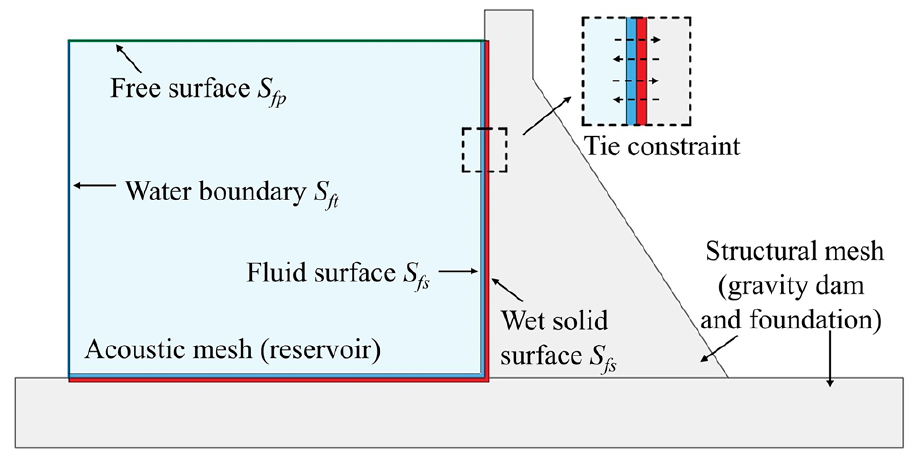
Figure 5. The coupled acoustic-structural method.